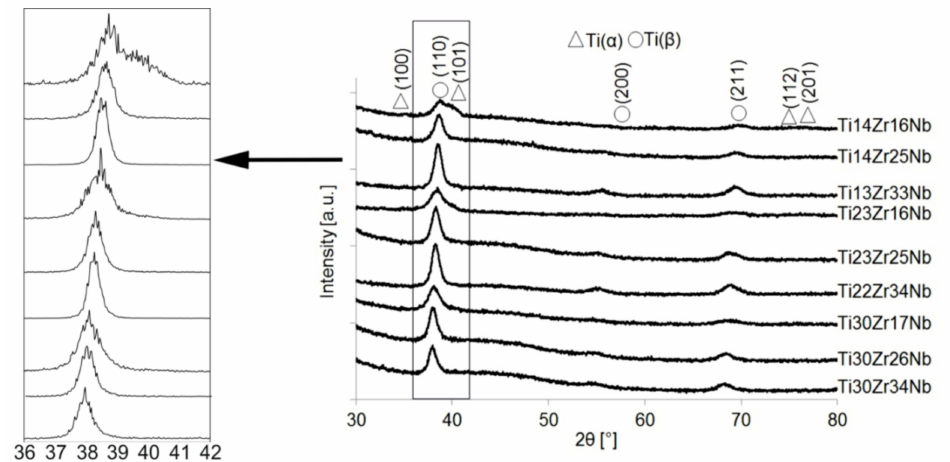
Figure 1. X-ray di ff raction (XRD) spectra of Ti-Zr-Nb powders mechanically alloyed for 10 h.